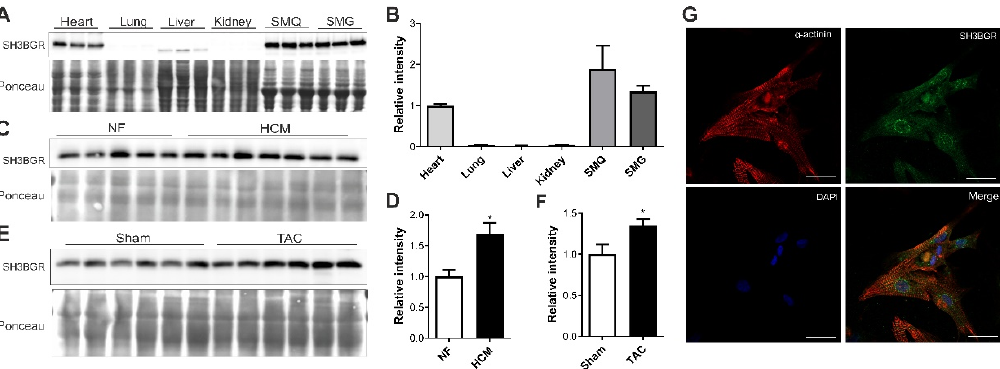
Figure 1. Expression pattern of SH3BGR. SH3BGR expression was observed to be confined to heart and skeletal muscle at protein level from mouse tissue lysates as shown in ( A ); its densitometric analysis is shown in ( B ) ( n = 3). ( C ) SH3BGR was identified to be upregulated in human patient heart samples suffering from cardiac hypertrophy (HCM, n = 7) as compared to non-failing (NF, n = 5) samples. Its densitometric analysis is shown in ( D ). SH3BGR upregulation was also observed in mouse hearts subjected to TAC surgery as compared to SHAM as shown in ( E ); its densitometric analysis is shown in ( F ) ( n = 6). ( G ) Immunofluorescence microscopy suggests sarcomeric and perinuclear localization of SH3BGR in NRVCMs. Statistical calculations were carried out using a two-tailed Student’s t -test. *, p < 0.05; SMQ, skeletal muscle quadriceps; SMG, skeletal muscle gracilis; TAC, transverse aortic constriction.